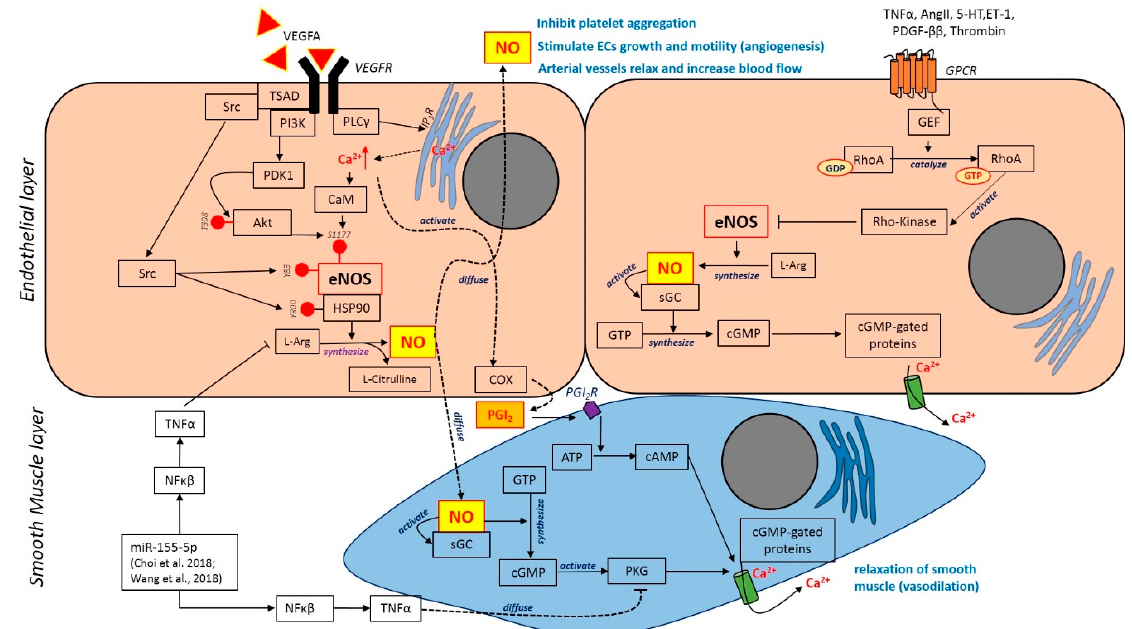
Figure 2. Targeted signalling pathway involved in endothelial cells (ECs) activation and vascular smooth muscle cells (VSMCs) proliferation and migration during intimal hyperplasia. The binding of vascular endothelial growth factor A (VEGFA) to its receptor VEGFR2 on ECs activates the PI3K pathway. Activated PDK1 phosphorylates Akt at Thr308 then phosphorylates eNOS at Ser1177 activating eNOS. VEGFA aslo activates the PLC γ pathway which increase Ca 2+ concentration and activates eNOS via calmodulin (CaM). The binding of VEGFA also activates Src kinase which then activates eNOS through two mechanisms: (1) phosphorylation of Tyr83 on eNOS; (2) phosphorylation of heat shock protein 90 (HSP90) at Tyr300. Those phosphorylation causes the binding of HSP90 to eNOS and activates NO synthesis. Activated eNOS converts L-arginine in the presence of oxygen to L-citrulline and diffusible signalling molecule NO. NO secreted by ECs inhibits platelet aggregation to avoid thrombosis. NO diffuses into vessel walls, causing arterial vessels to relax and increase blood flow. The binding of agonist to G-protein– coupled receptors (GPCR) induces activation of Rho-kinase activity via GEF activation. The activity of RhoA is controlled by the guanine nucleotide exchange factors (GEFs) that catalyse the exchange of GDP for GTP. Rho-kinase activity is enhanced by binding to the active GTP-bound RhoA. However, this mechanism is negatively regulating eNOS activation for NO production. Diffused NO binds to its intracellular receptor soluble GC (sGC) which produces cGMP from GTP. The increase in intracellular cGMP concentration bind to cGMP-dependent protein kinases (PKGs) and cGMP-gated ion channels results the increase of Ca 2+ and relaxation of smooth muscle.